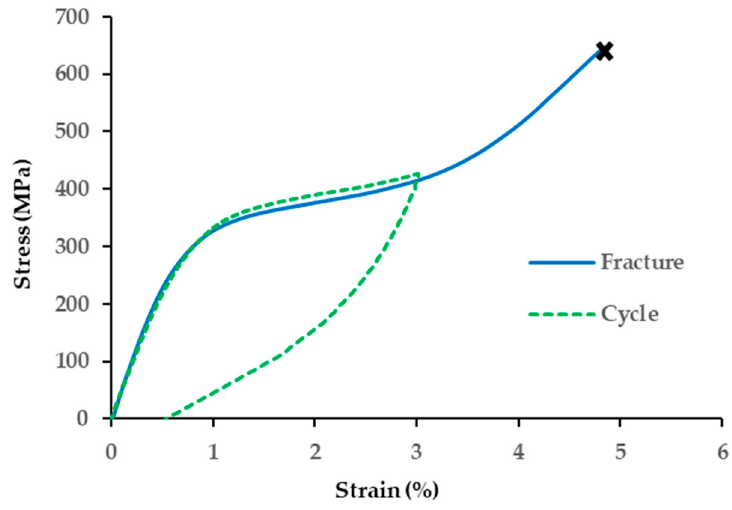
Figure 8. Stress–strain response of SLM dog-bone samples.